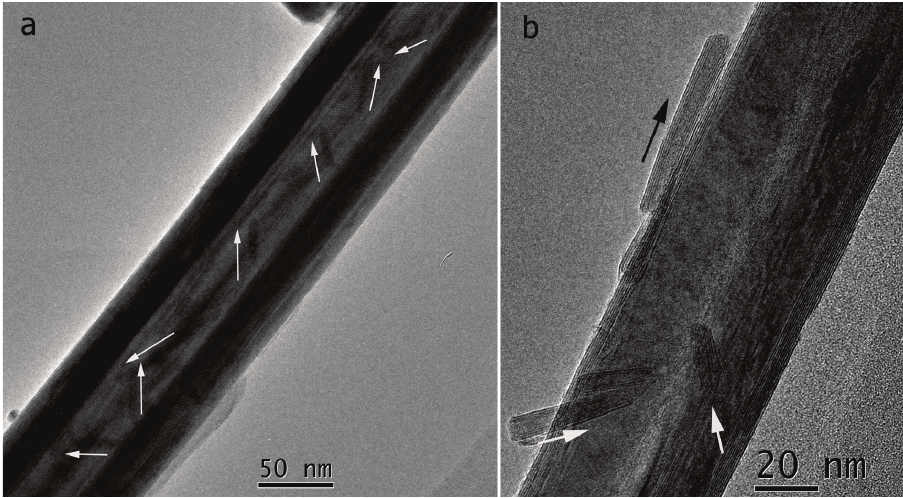
Figure 4. ( a ) TEM images of the daughter nanotubes tethered to the surface and tilted at approximately 30 or 60° with respect to the mother nanotube growth axis (white arrows); ( b ) TEM image of a daughter nanotube with growth axis parallel to the mother nanotube (black